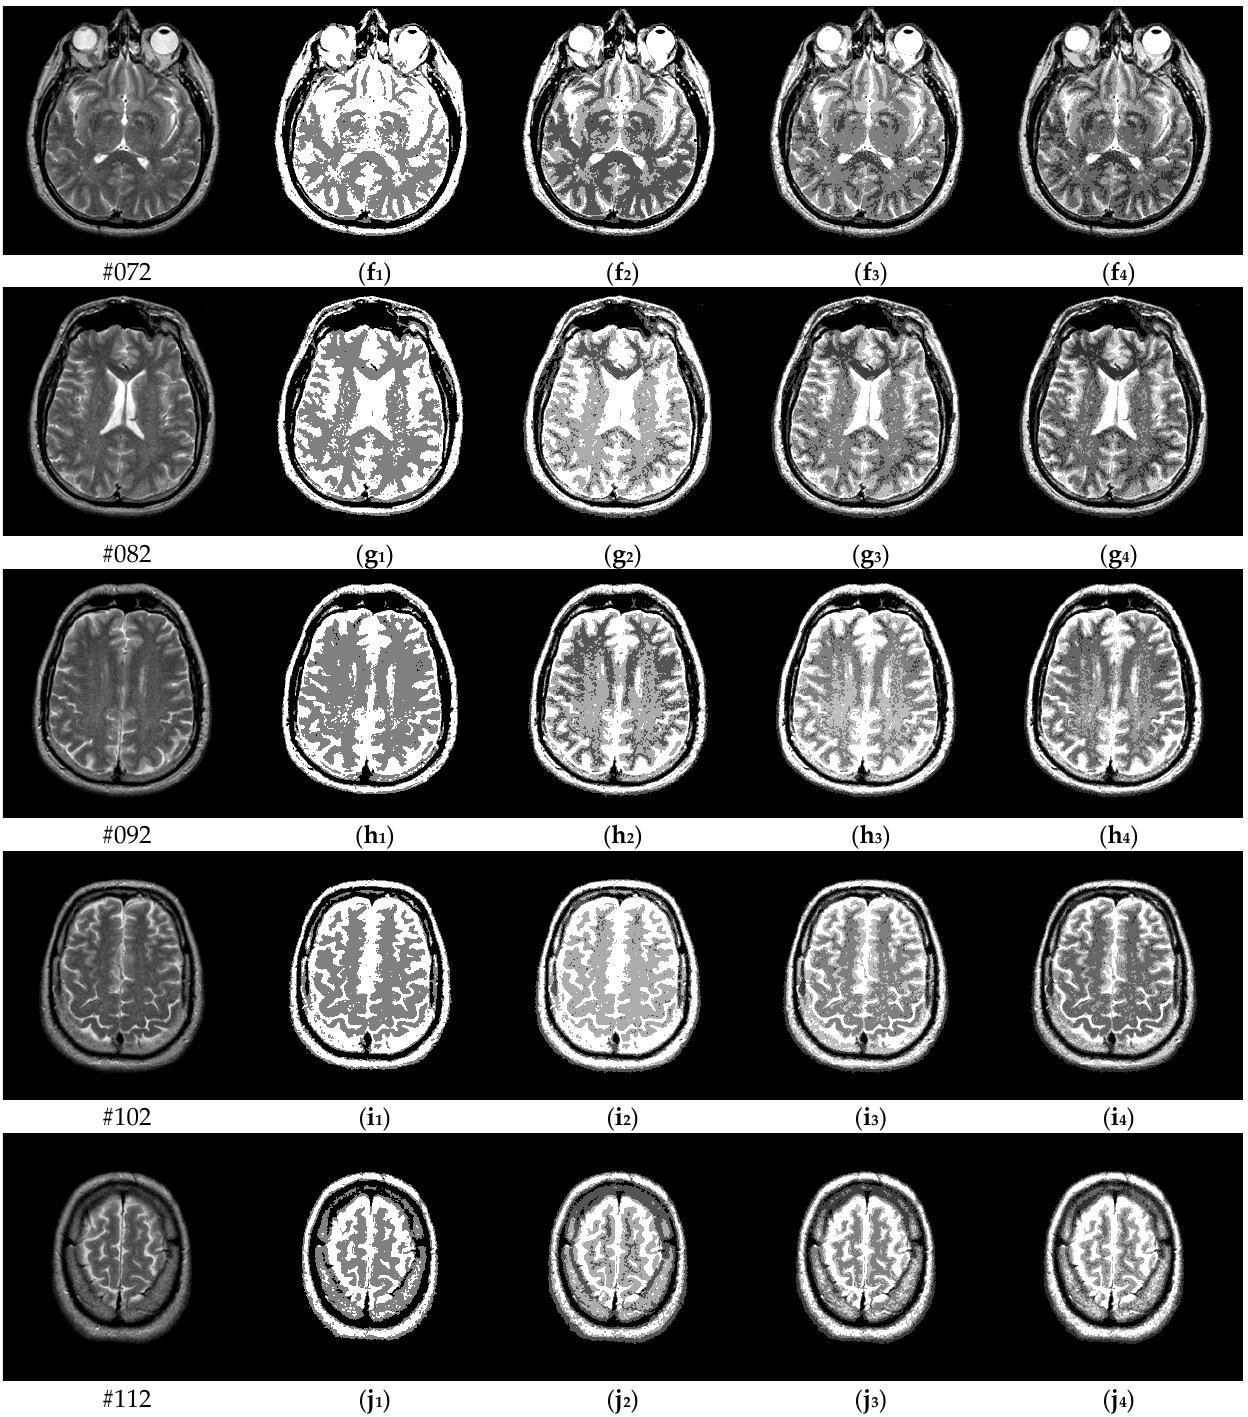
Figure 8. Segmentation results obtained by the proposed algorithm for brain slices #022~#112; ( a 1 – j 1 ) display the results of 2-thresholding; ( a 2 – j 2 ) display the results of 3-thresholding; and ( a 3 – j 3 ) display the results of 4-thresholding; ( a 4 – j 4 ) display the results of 5-thresholding. The uniformity measures ( U ) values of the proposed algorithm and other comparison algorithms with K = 2, 3, 4, 5, respectively, are shown in Table 2. The highest U values are marked in bold. In general, our proposed algorithm achieves the best or better evaluation results on all test images. For #042, #052, #062, #082, #112, the proposed algorithm achieves suboptimal results when K = 5. The difference of the objective evaluation U value is small